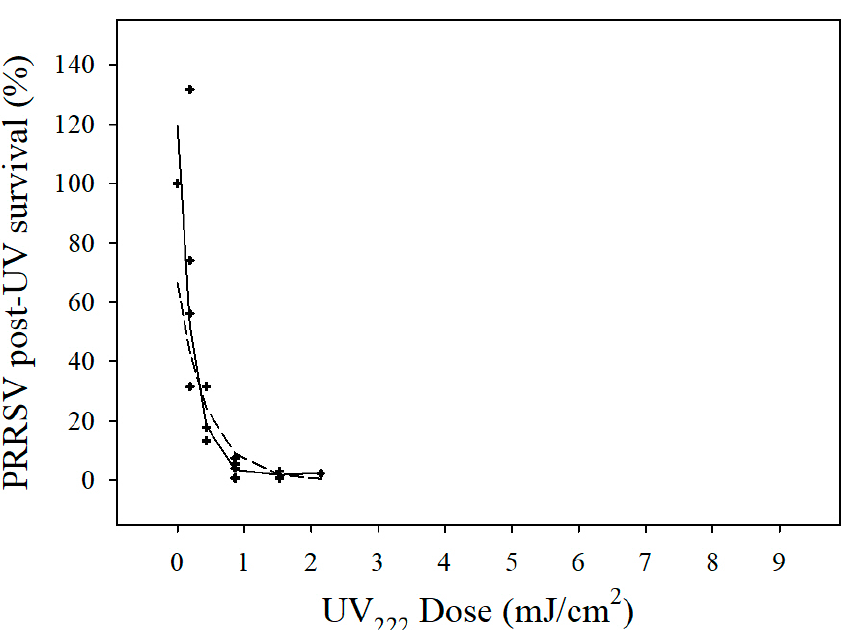
Figure 3. UV-C (222 nm) treatment inactivation of aerosolized PRRSV. PRRSV post-UV survival (%) = N t /N 0 . A log 10 normalized PRRSV post-UV survival is shown in Figure A2. One-stage and two-stage inactivation models are marked with dashed and solid lines, respectively.